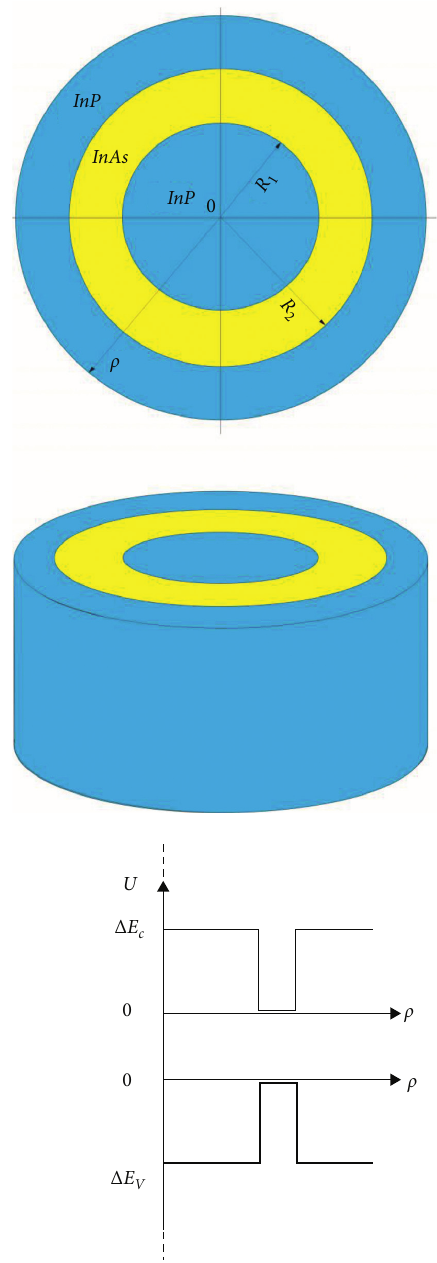
Figure 5: The geometric and potential scheme of a cylindrical quantum nanorod with a finite potential